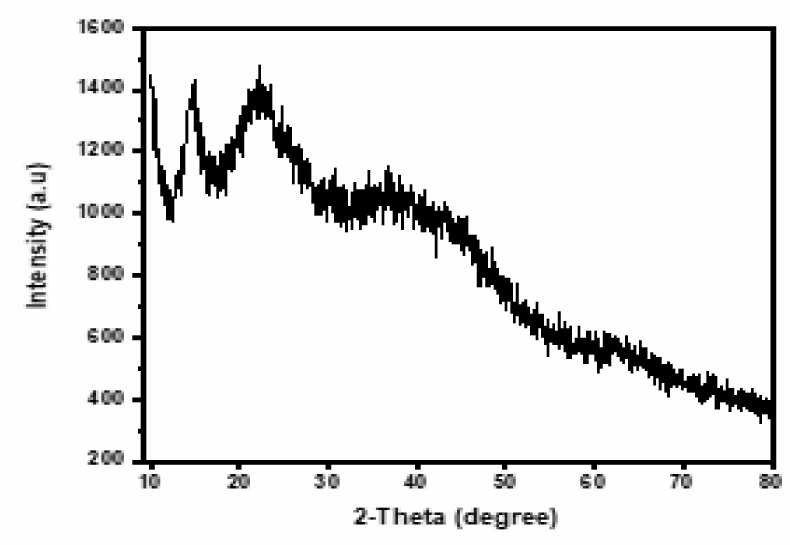
Figure 4. Powder XRD patterns for the PANI@Al-SA MOF